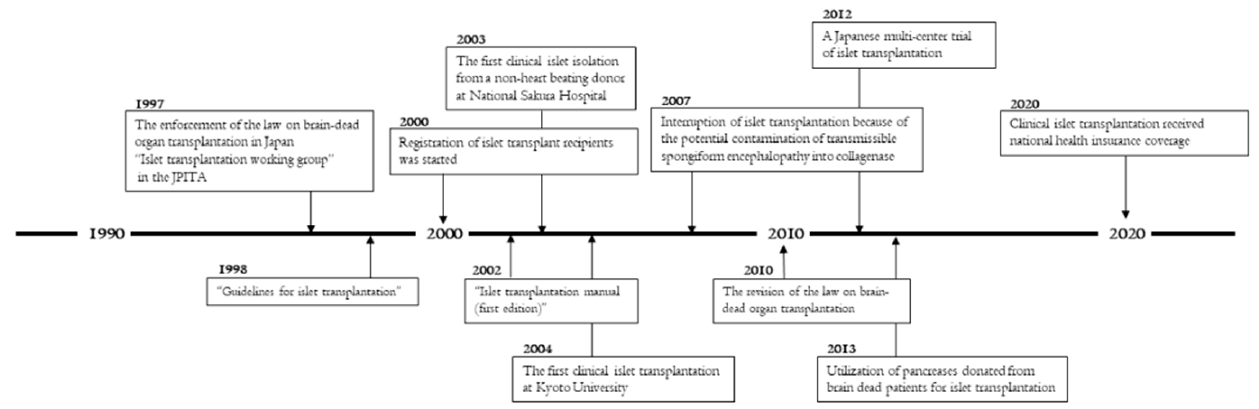
Figure 1. Remarkable events for islet transplantation in Japan.